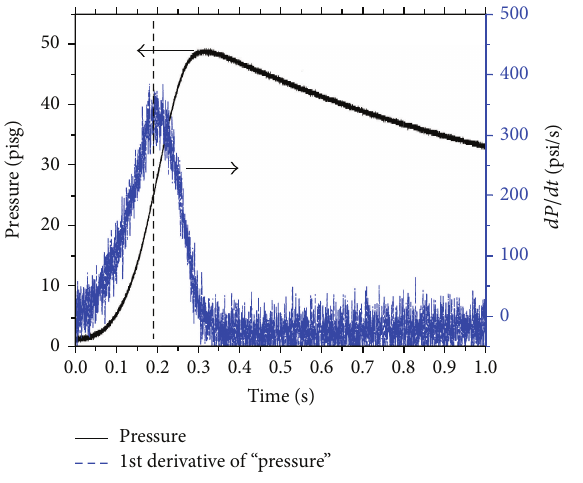
Figure 4: Sample pressure-time data from a sulfur explosion.